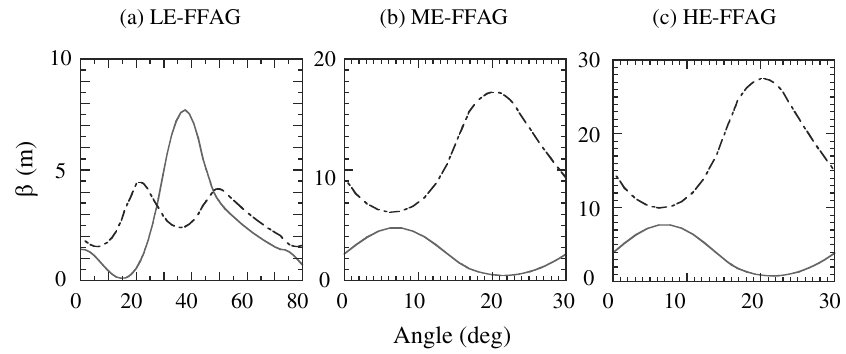
FIG. 8. (cid:23) functions of the (a) LE, (b) ME, and (c) HE rings at extraction orbit.